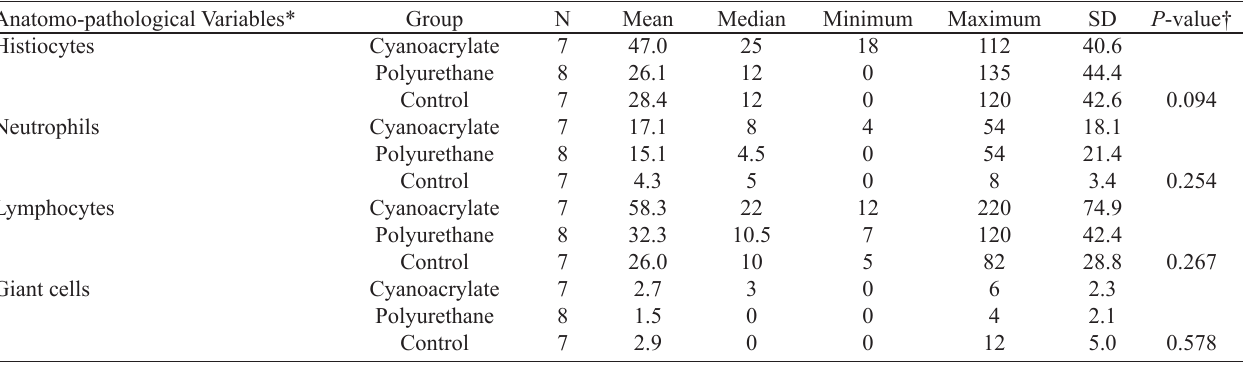
Table 3. Comparison of groups I, II, and III in relation to the histological quantitative variables. Anatomo-pathological Variables*